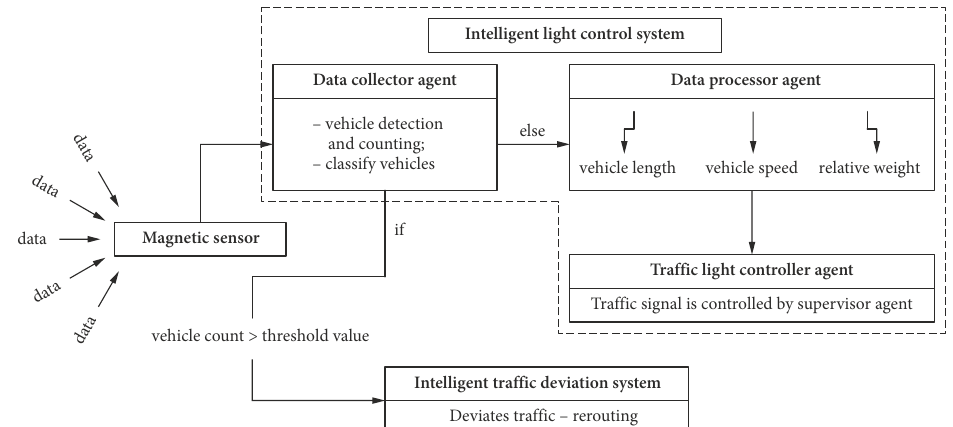
Figure 2. Architecture of the proposed